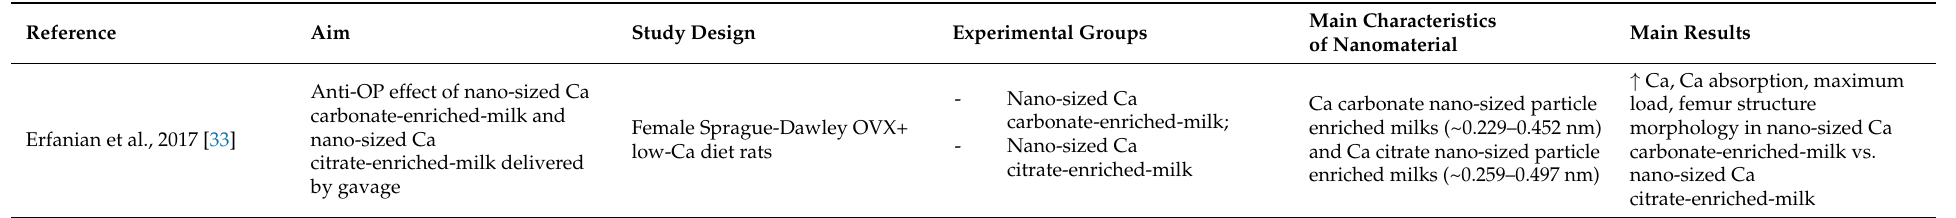
Table 3. Preclinical in vivo studies where oral delivery, transdermal delivery, and intranasal delivery approaches were used for the delivery of drugs through nano-based materials in OP